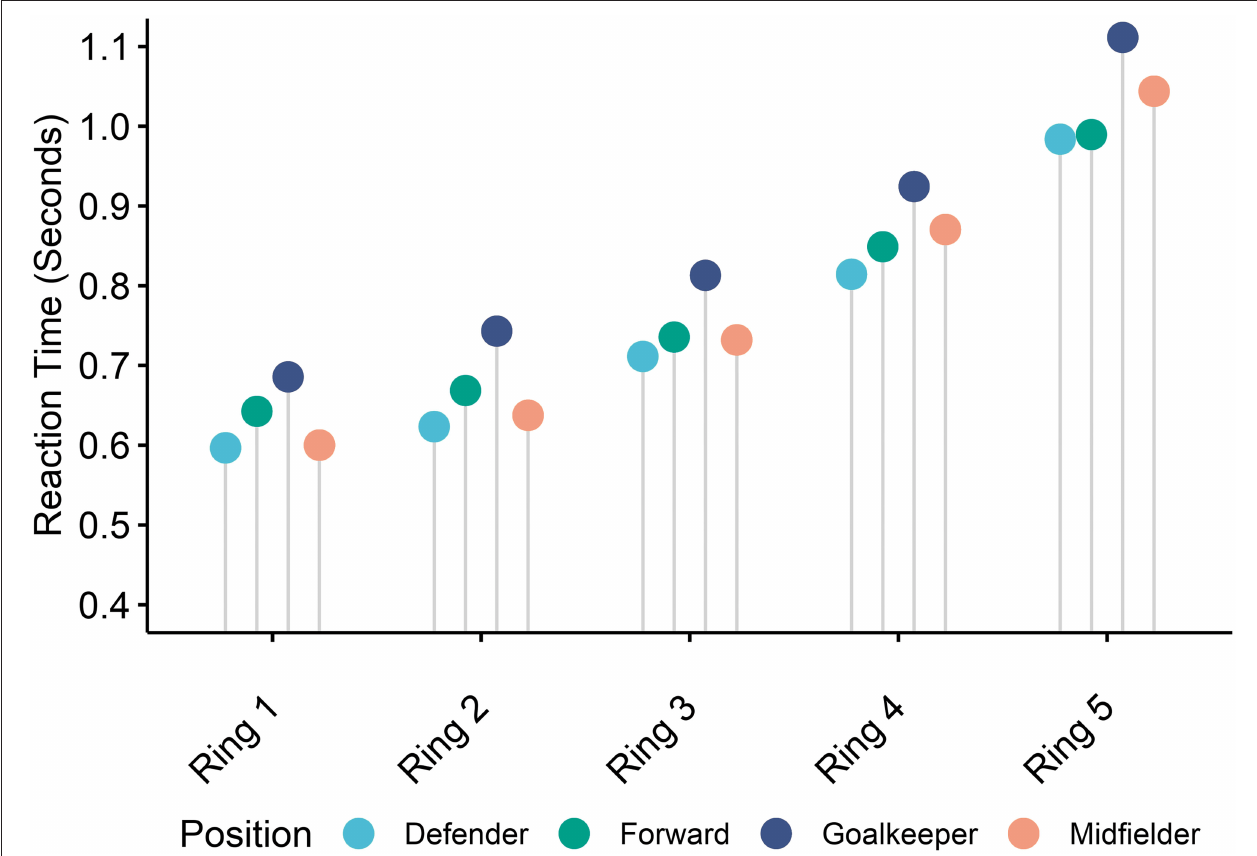
FIGURE 4 | Average reaction time by region during the Endurance task. The figure demonstrates the average reaction time in seconds for each of the five rings of the Dynavision board across positions during the Endurance task.